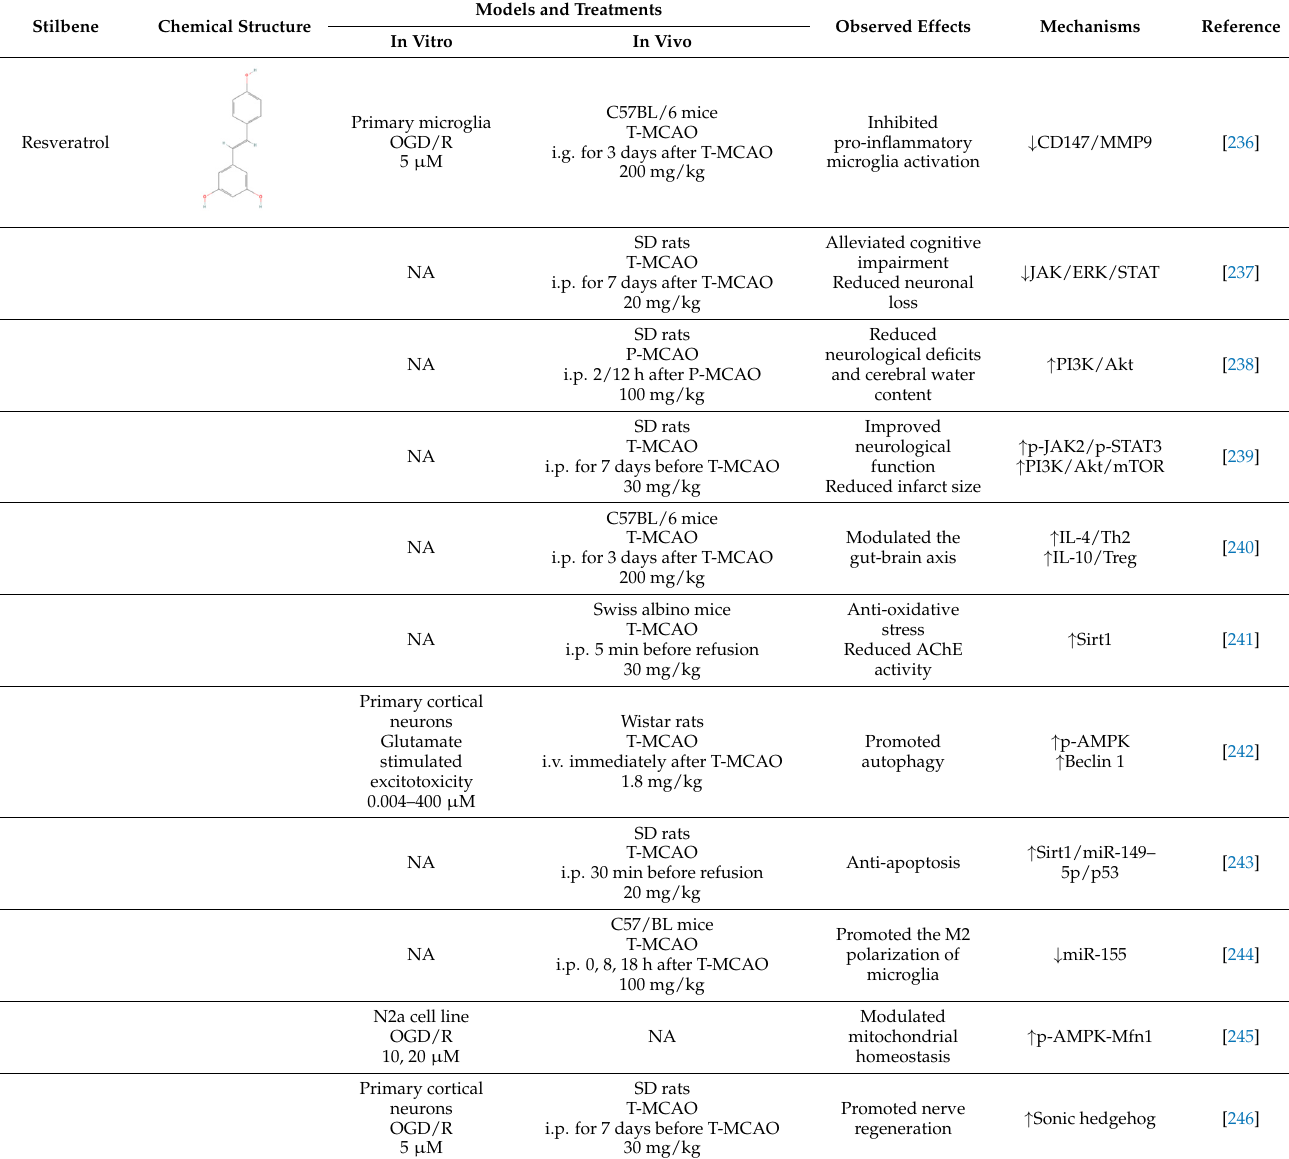
Table 4. Summary of recent studies on anti-IS effects of stilbenes. Models and Treatments Stilbene Chemical Structure